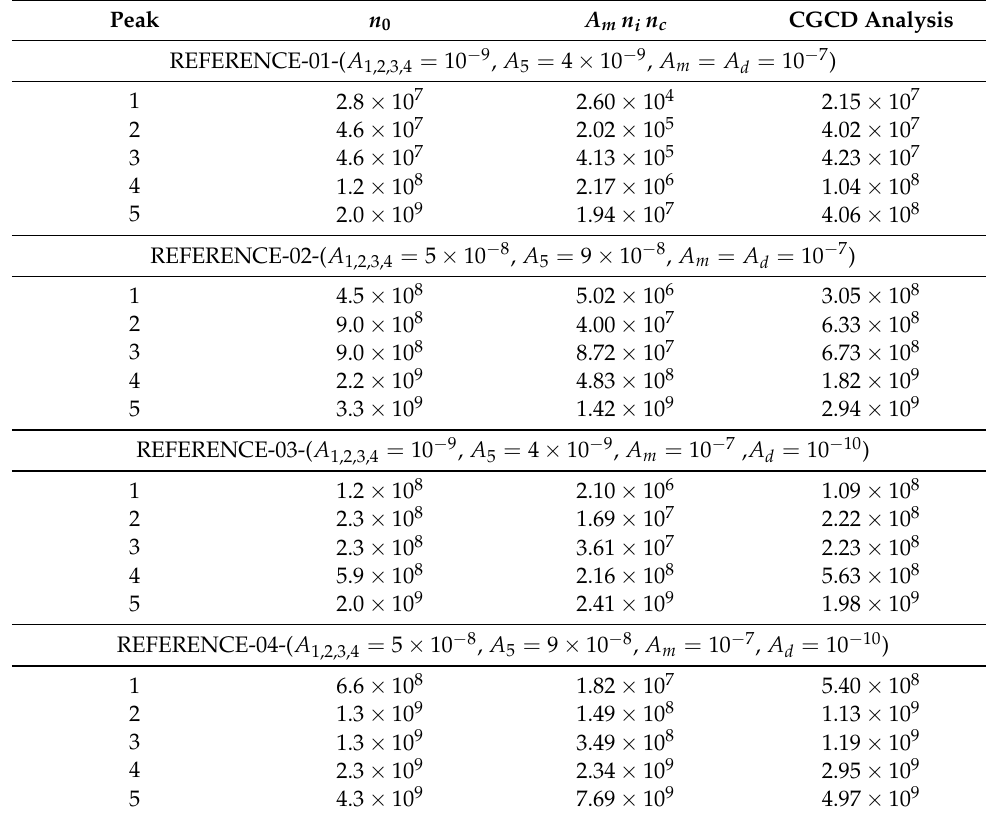
Table 1. Individual peak integral evaluations. The first column corresponds to the number of electrons n 0 trapped in each trapping level, at the end of irradiation stage. The second column shows the integrated signal of the contribution of each term A m n i n c and the third column corresponds to the integrated signal of each peak obtained from the CGCD